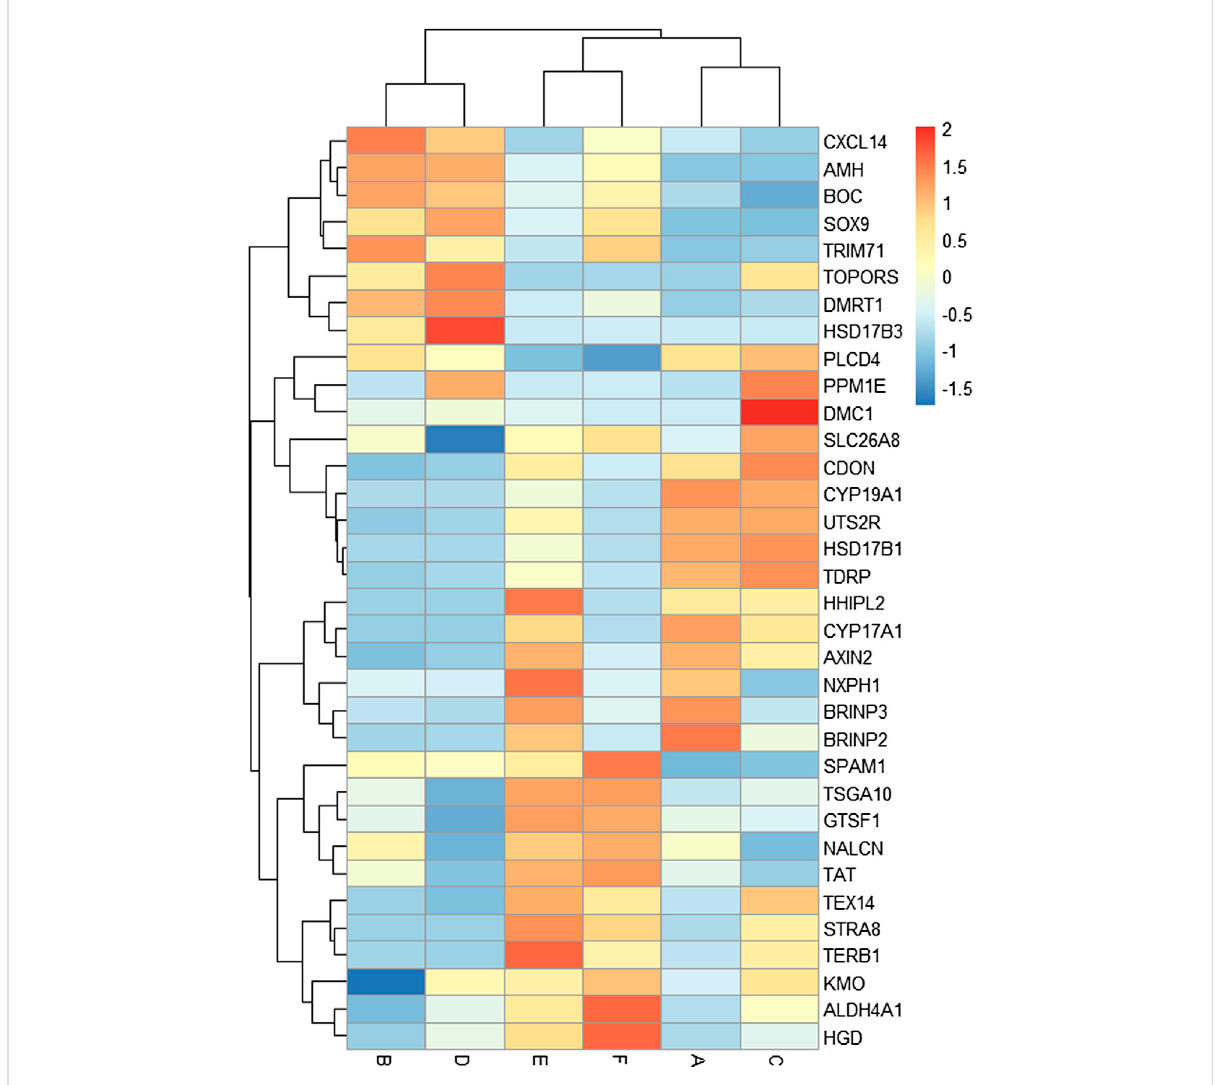
FIGURE 5 Heat map of the expression levels of key candidate genes related to gonadal development and sterility in Mule ducks. Red represents a high expression level, and blueindicates a low expression level. Columns and rows represent samples and genes, respectively. The color scale represents fold changes in gene